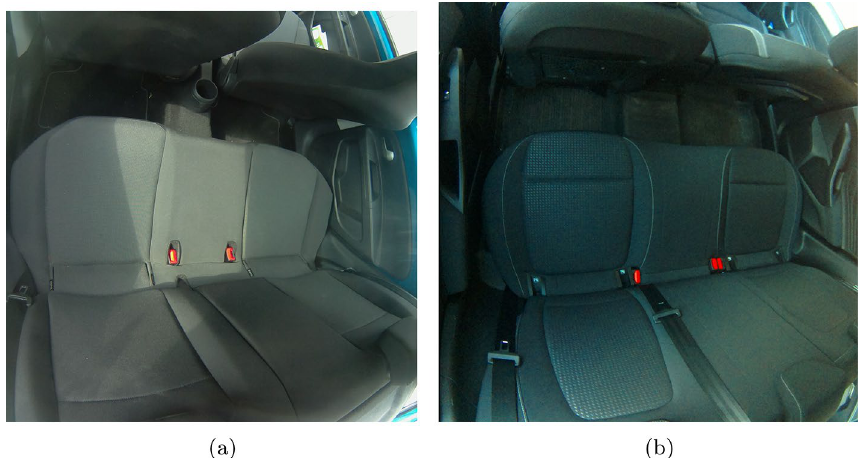
Fig. 2 Scope of detection with respect to the camera location of the two vehicles: a SEAT MII b Aalto Ford Focus